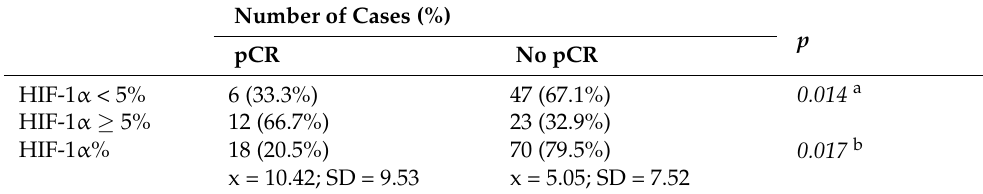
Table 2. Relation between HIF-1 α expression and pCR.